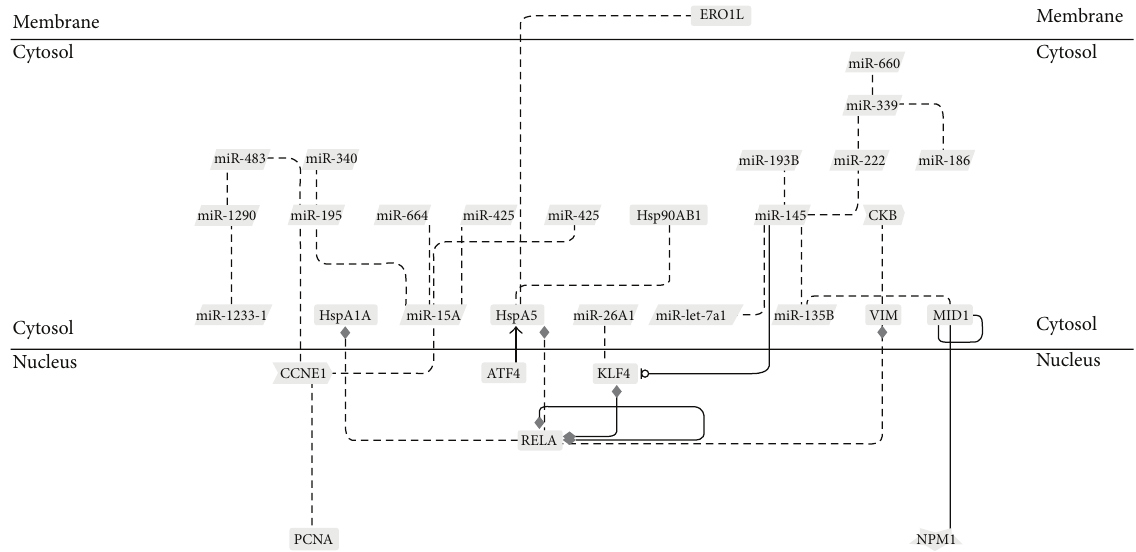
Figure 4: Interaction network of microRNAs, proteins, and genes in hMB-SLCs by means of GePS analysis.